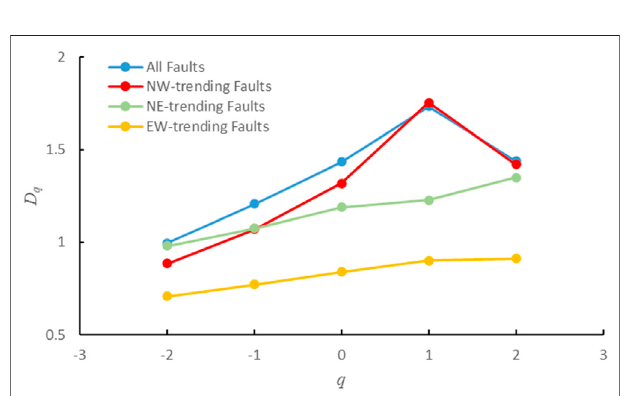
FIGURE 8 | Relationship between D q and q